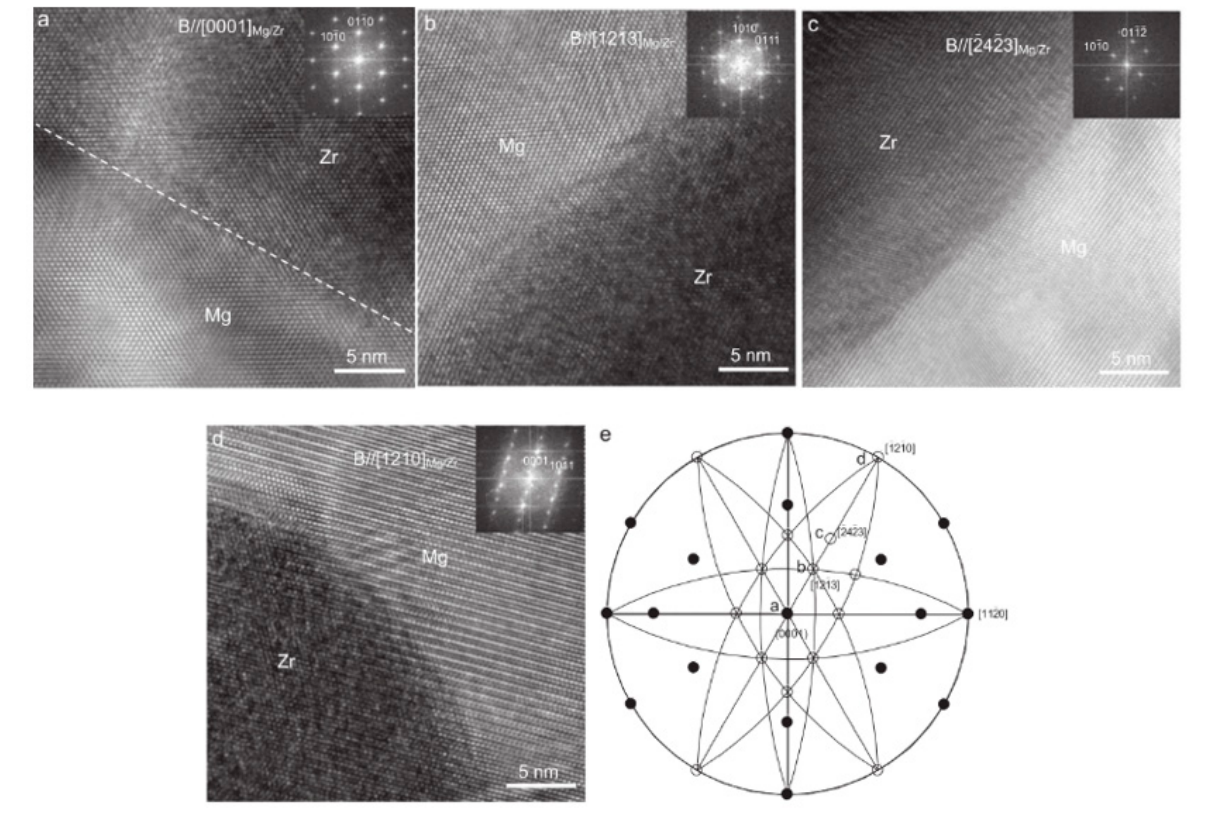
Figure 6. HRTEM images showing: ( a ) faceted interface; ( b – d ) curved interfaces between α -Mg grains and Zr nuclei in Mg-0.1Zr alloy along four different low-index zone axes. ( e ) Stereographic projection of HCP structure showing the various ORs ( a – d ) within a 90° range [51]. Reprinted with permission from ref. [51]. Copyright 2015 Elsevier.